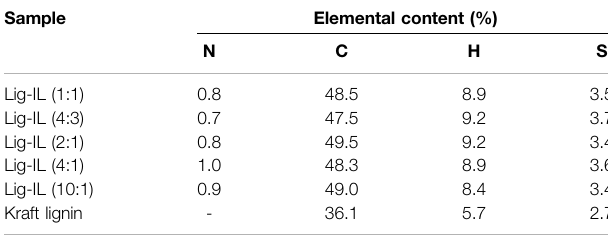
TABLE 3 | Elemental analysis of all prepared materials.